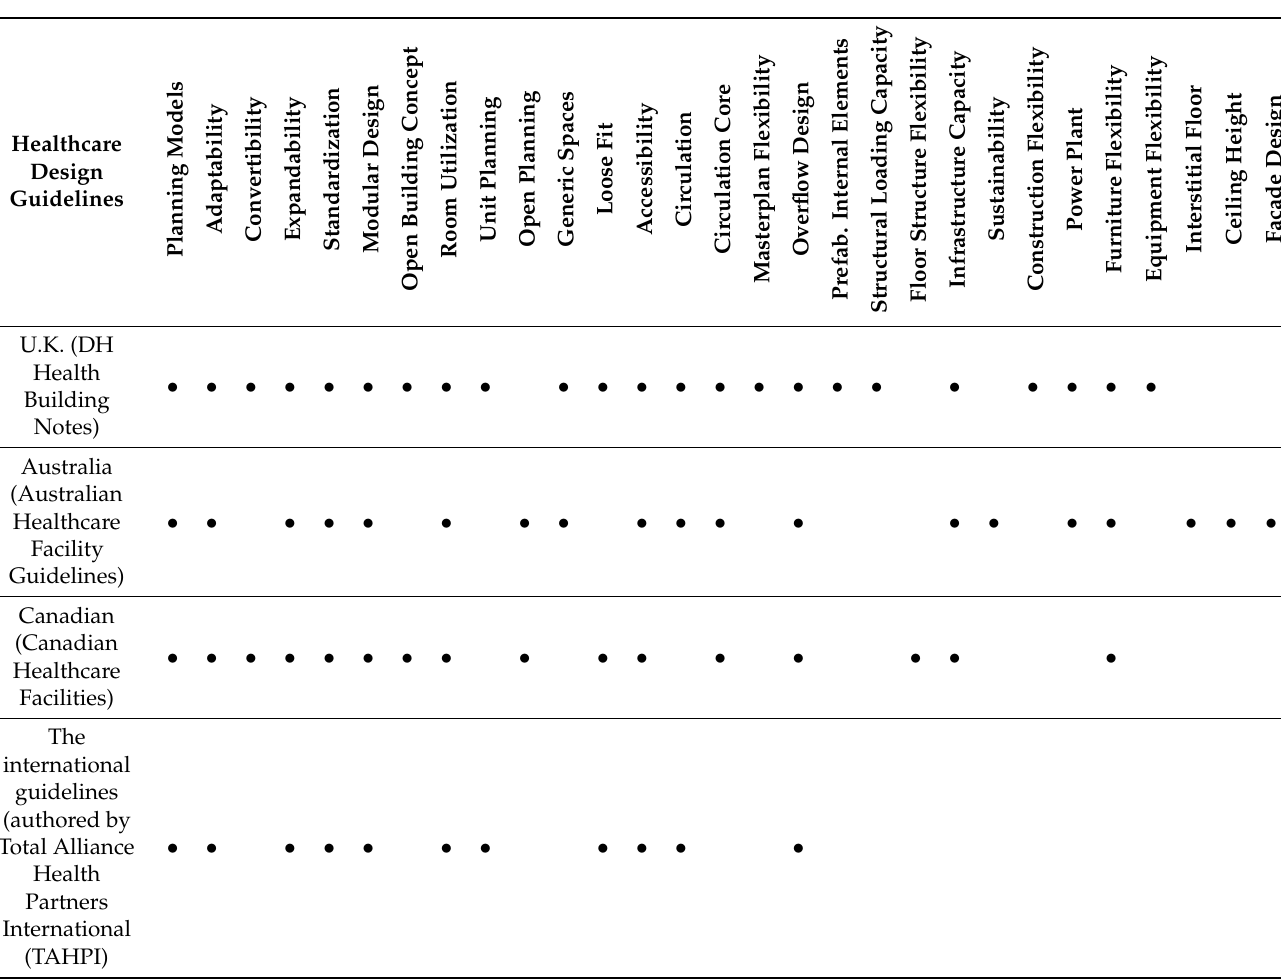
Table 6. Flexibility principles matrix for healthcare